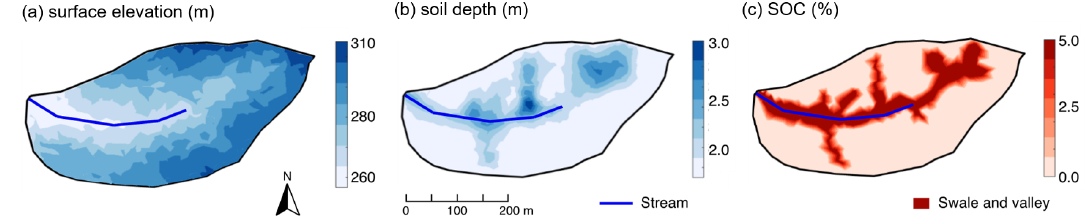
Figure 9. Attributes of Shale Hills in the spatially distributed mode in Example 3: (a) surface elevation, (b) soil depth, and (c) soil organic carbon (SOC). The surface elevation was generated from lidar topographic data (criticalzone.org/shale-hills/data); soil depths and SOC were interpolated using ordinary kriging based on field surveys (Andrews et al., 2011; Lin, 2006). The SOC distribution in (c) was further simplified using the high, uniform SOC (5% v/v ) in swales and valley soils based on field survey (Andrews et al., 2011). Swales and valley floor areas were defined based on surface elevation via field survey and a 10m resolution digital elevation model (Lin,